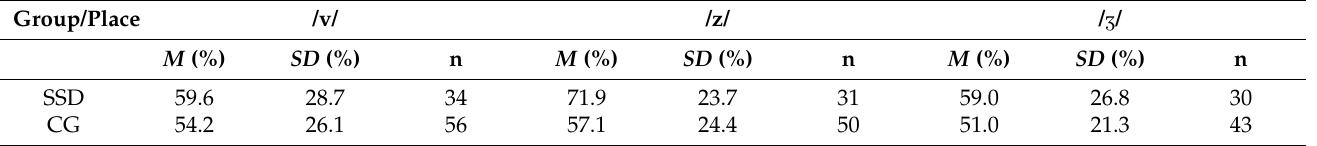
Table 5. Mean ( M ), standard deviation of the mean ( SD ) and number of samples (n) of OQ values for the three places of articulation: /v/—labiodental; /z/—alveolar; / Z Table 5. Mean (M), standard deviation of the mean (SD) and number of samples (n) of OQ values